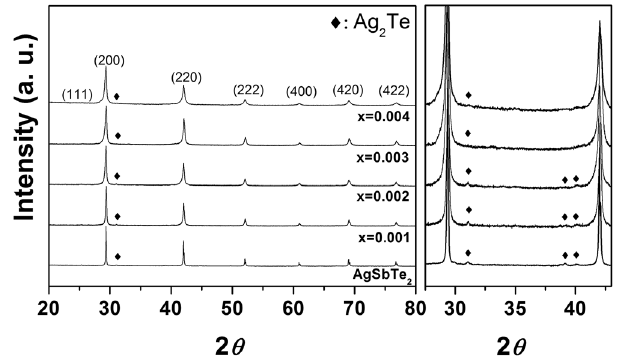
Figure 1. X-ray diffraction (XRD) patterns of Ce-doped AgSb 1 − x Ce x Te 2 samples; the phase of the AgSbTe 2 and the small amount of Ag 2 Te were detected in all samples; the right panel is the patterns focused on the region between 27.5 and 43 degrees.